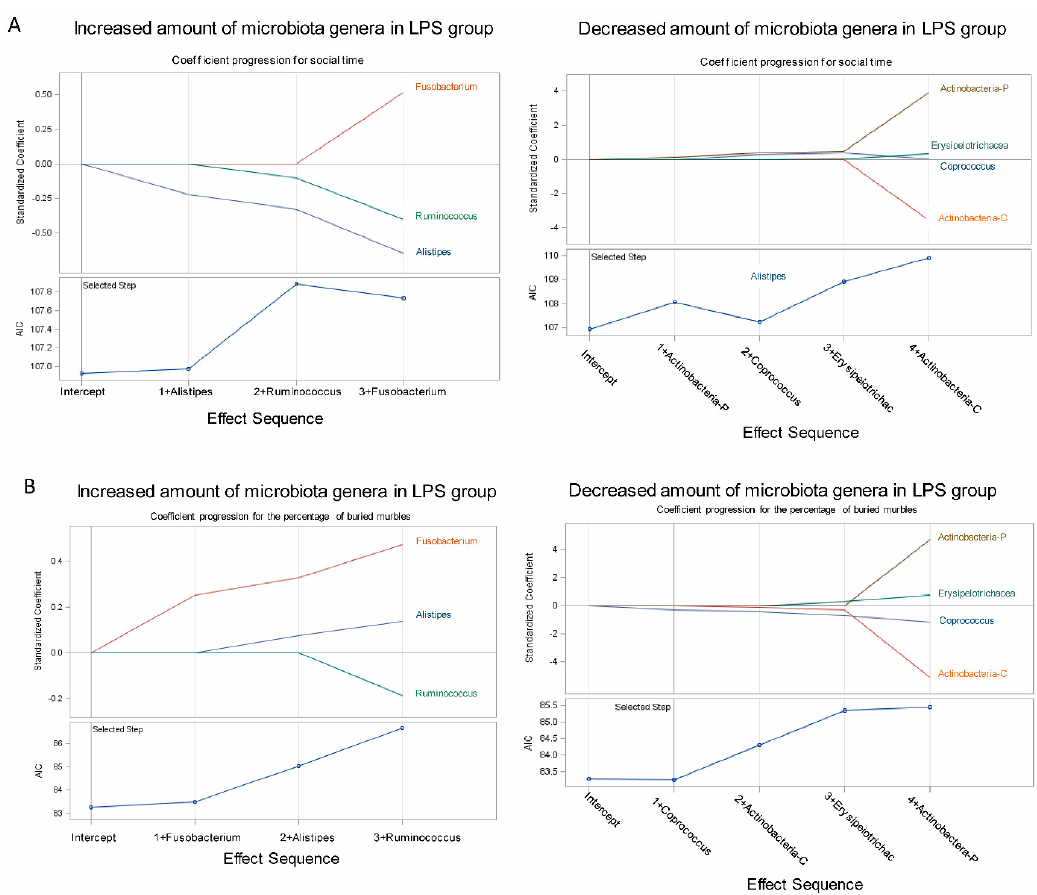
Figure 5. Feature importance of bacterial species for social behavior deficit and anxiety-like and repetitive behavior. ( A ) Standardized coefficients of the effects selected (the increased or decreased amount of microbiota genera in the lipopolysaccharide (LPS) group) with social time or ( B ) the percentage of buried marble at a given step of the stepwise method are plotted as a function of the step number. The coefficients plot displays the values of the estimates for each model at each iteration step. The effect was added into the model in an order of its relative importance measured with AIC. The plot labels the added effects at each step. The vertical axis of plot shows standardized estimates that can track the change of AIC for each successive model. Each colored line visualizes the evolution of values for a particular effect. The AIC plots show the relative importance of the effects selected (microbiota species) at steps of the selection process when effects entered the model. Actinobactera-P indicates the relative amount of phylum Actinobacteria . Actinobacteria-C indicates the relative amount of class Actinobacteria .